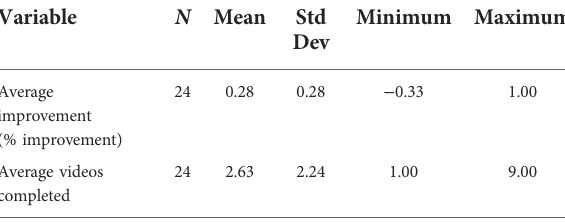
TABLE 3 Educational video patient and family demographics. TABLE 4 Patient/family educational video improvement scores.